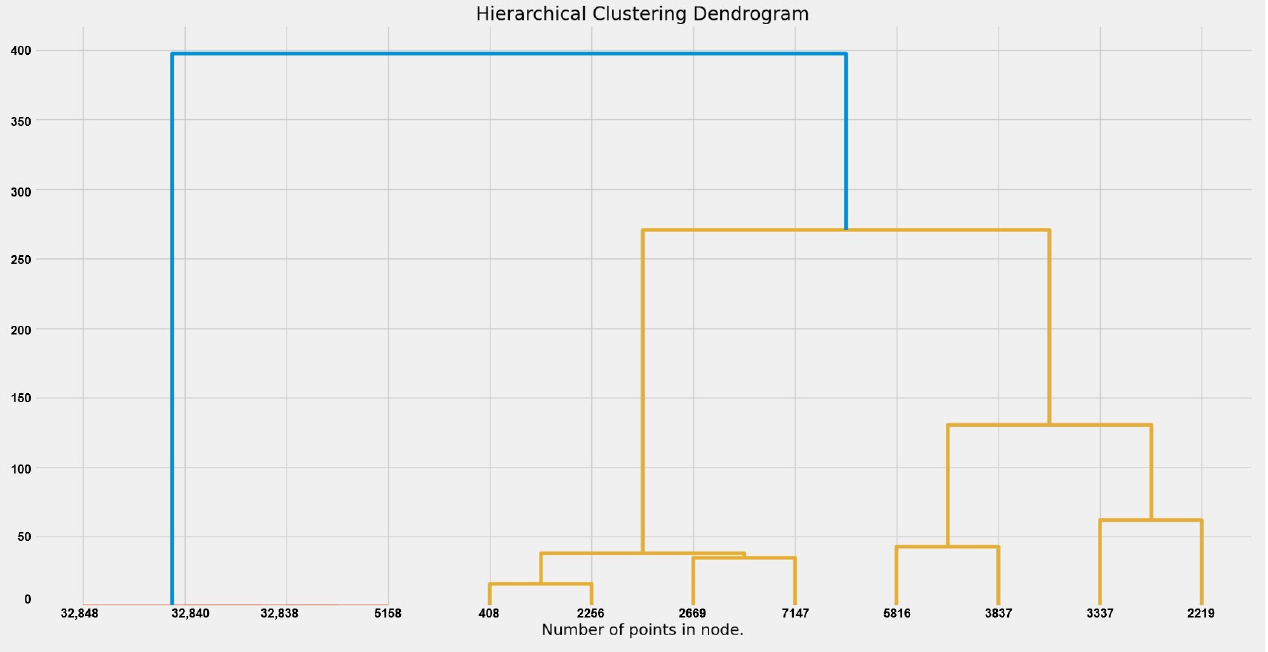
Figure 4. Hierarchical clustering dendrogram for IEEE-24 bus dataset.